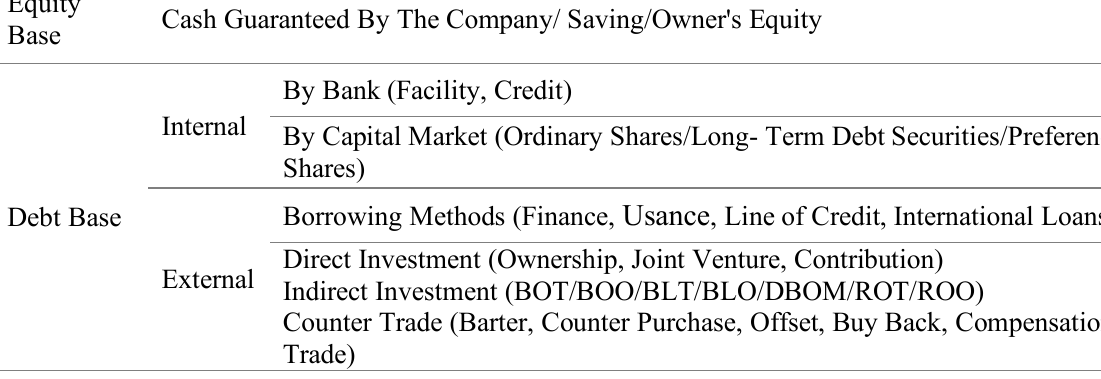
Table 1 . Sources of financing